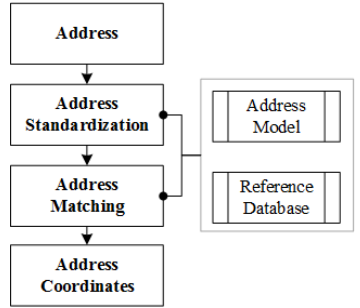
Figure 2. The geocoding process.